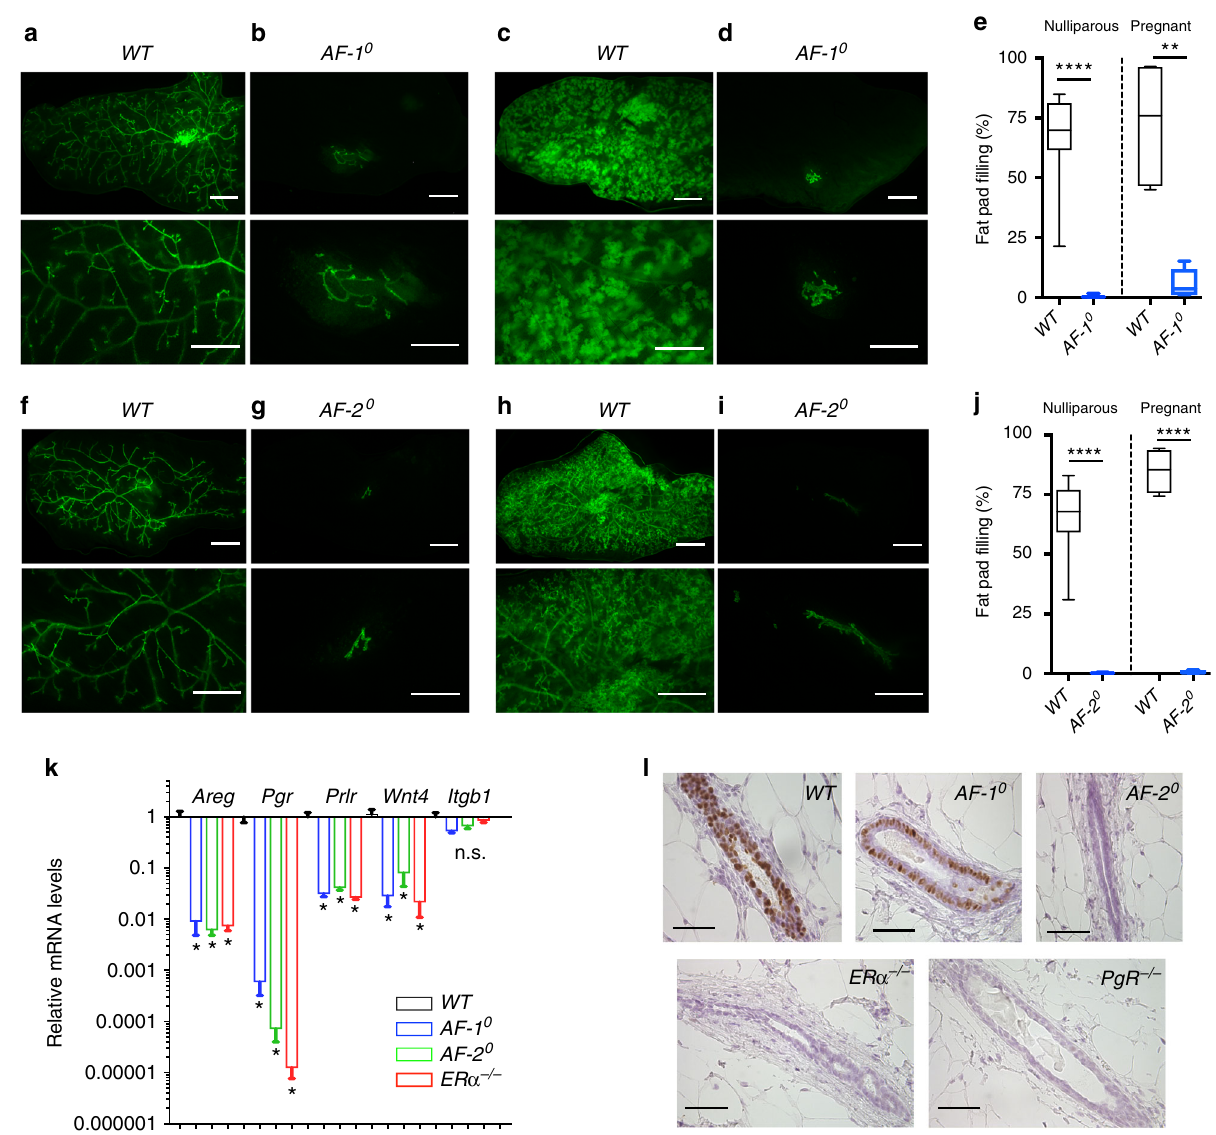
Fig. 3 Mammary epithelial-intrinsic role of the ER α AF-1 and AF-2 domains. a – d Fluorescence stereomicrographs of contralateral inguinal mammary fat pads engrafted with mammary epithelium from AF-1 0 .GFP + or WT.GFP + littermates. Nulliparous ( a , b ) and day 16 – 18 pregnant ( c , d ) recipients are shown. Scale bars; 5 mm (top), 2mm (bottom). e Box plot showing extent of fat pad fi lling by the engrafted epithelia in virgin ( n = 18) and pregnant ( n = 5) recipients. f – j Fluorescence stereomicroscopy of contralateral inguinal mammary fat pads engrafted with mammary epithelium from AF-2 0 .GFP + or WT.GFP